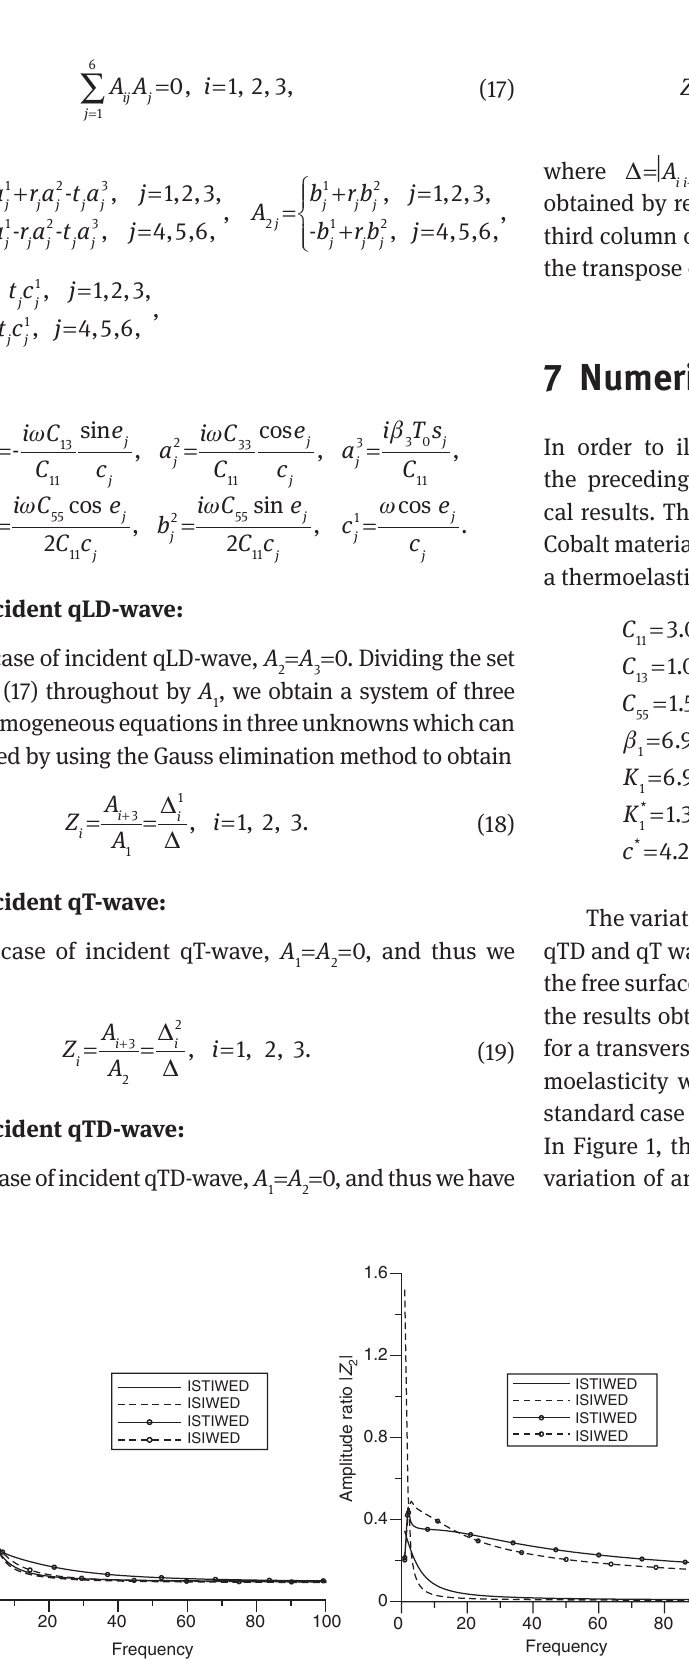
| ( i = 1, 2, 3) with frequency for incident i